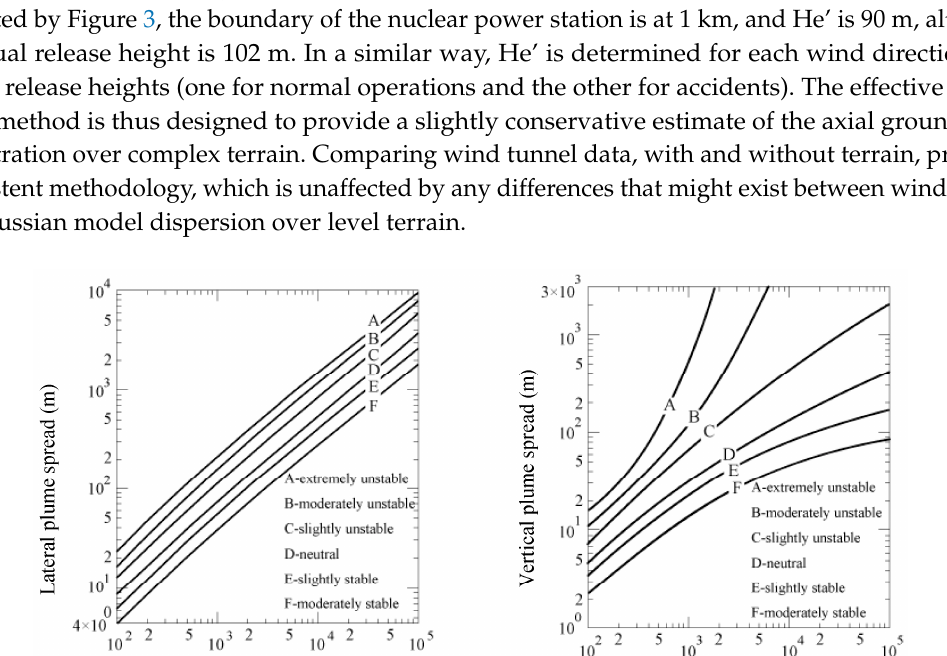
Figure 2. Pasquill-Gifford chart of plume spreads [5]. ( a ) Lateral plume spread; ( b ) Vertical plume spread.